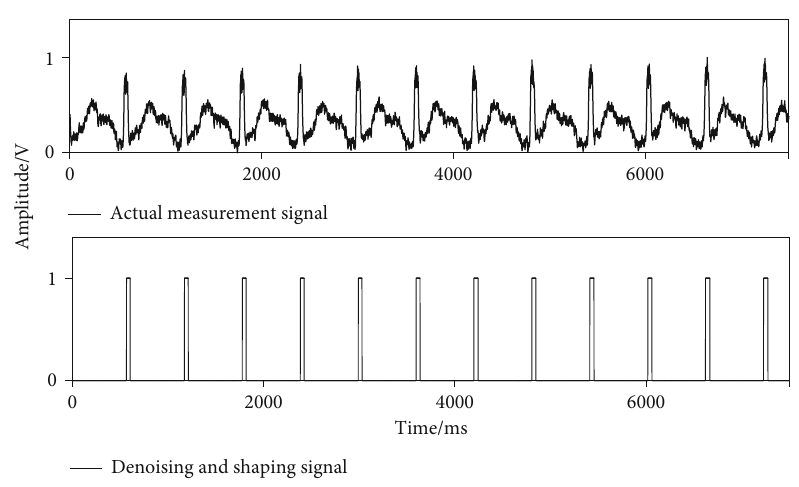
Figure 14: Denoising and shaping e ff ect for actual BTT signal.